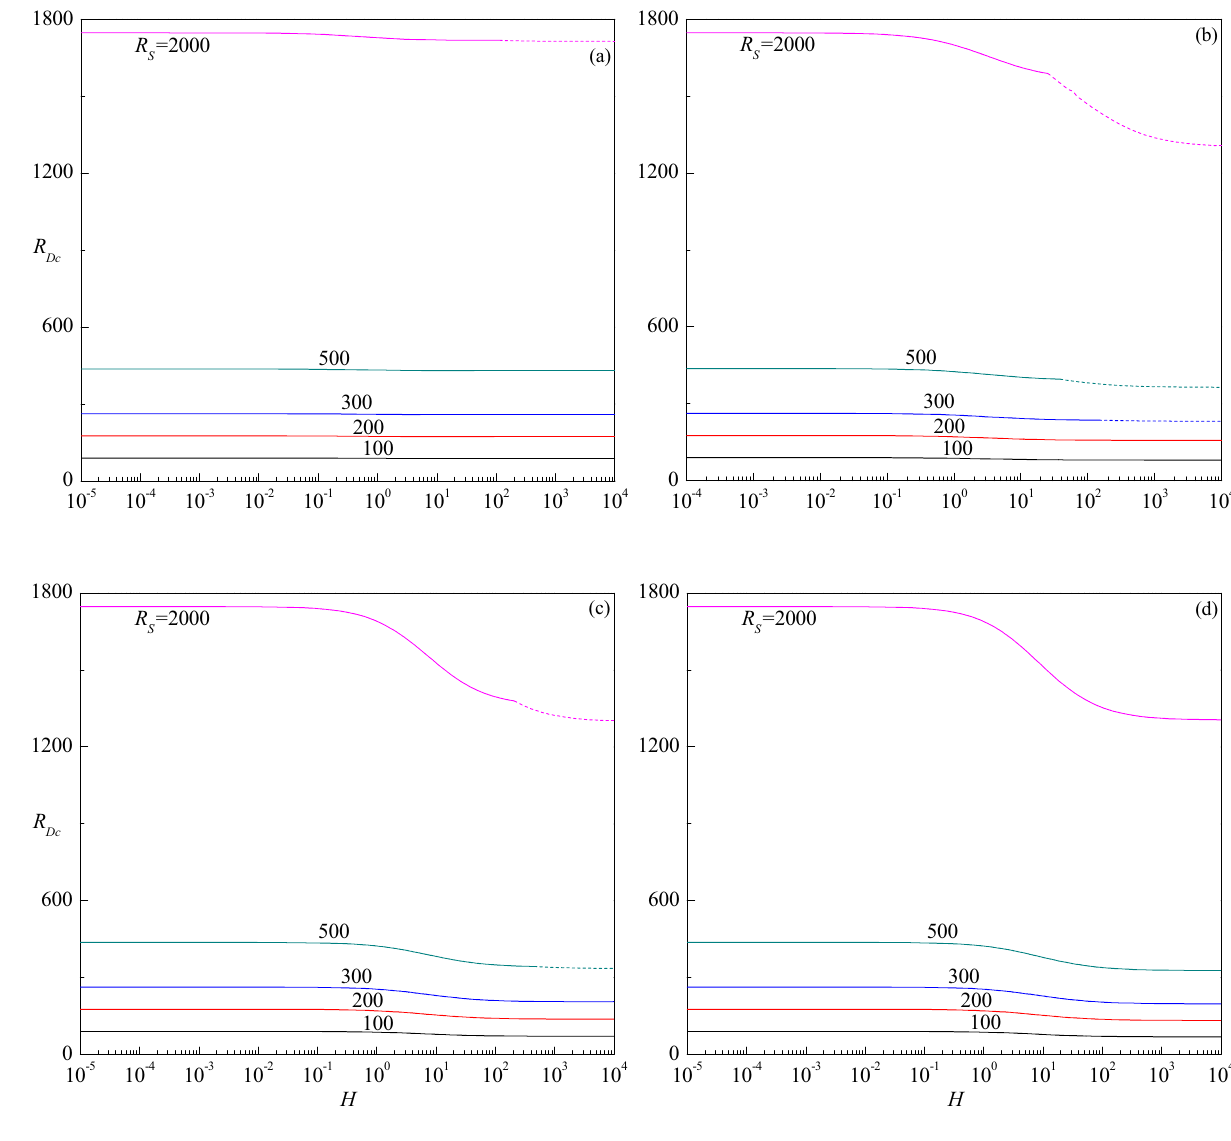
Figure 9. The variation of R Dc versus H for different values of R S relative to the cases ( a ) γ = 10 , ( b ) γ = 1 , ( c ) γ = 0.1 and ( d ) γ = 0.01 when Le = 2